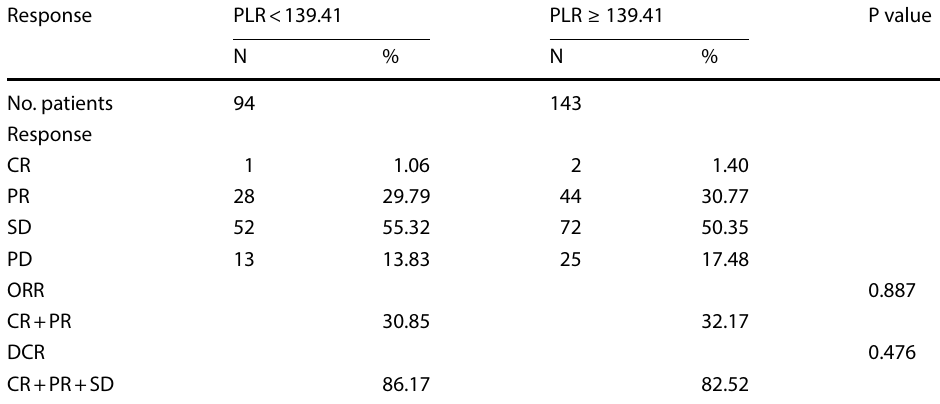
Table 2 Treatment response in the PLR < 139.41 group and in the PLR ≥ 139.41